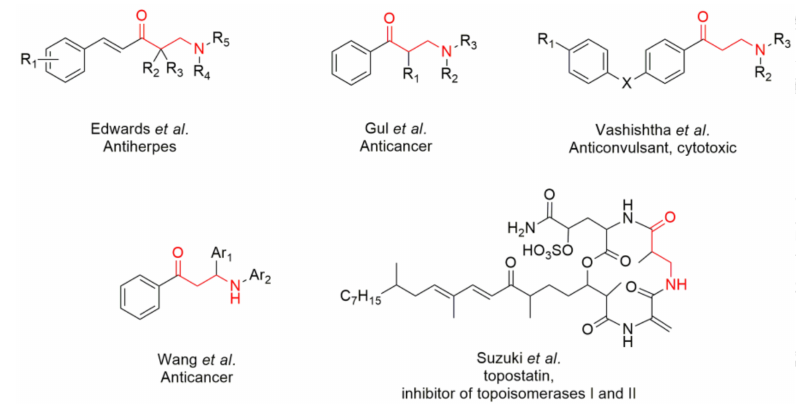
Figure 1. Some important β -amino ketones, both synthetic and natural, and their biological properties.